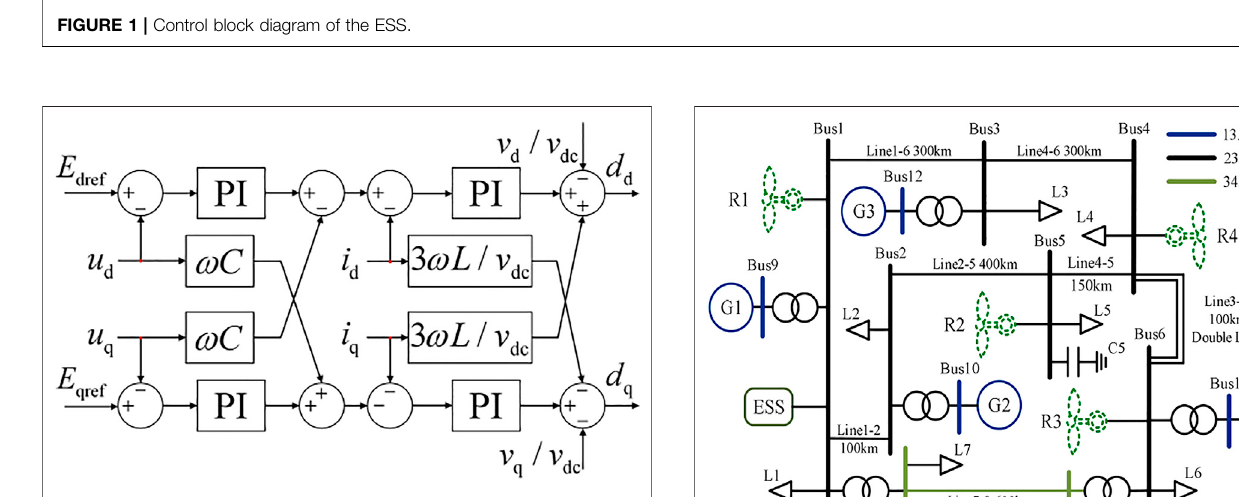
FIGURE 2 | Voltage and current double loop control.